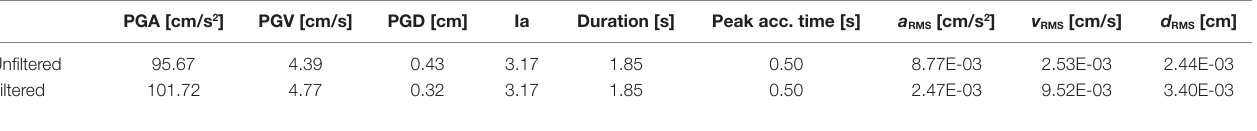
TaBle 3 | signal properties of the unfiltered vs. filtered records (Friuli